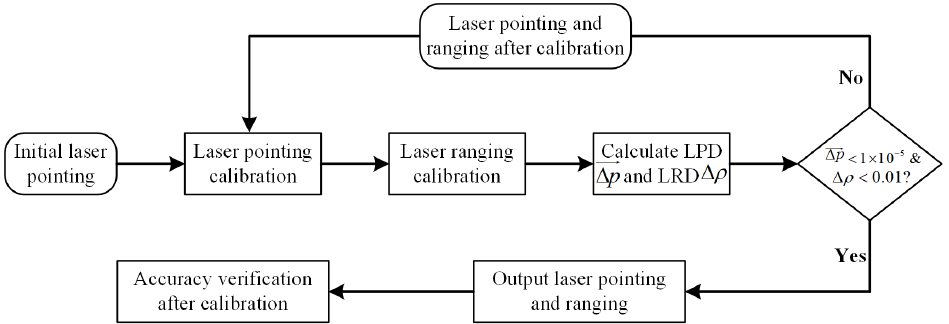
Figure 4. The GCPs around a GF ‐ 7 laser footprint. ( a ) The GCP array surrounding laser point 203168336.67 of GF ‐ 7 laser beam 1. ( b ) A picture of the GCP measurement.